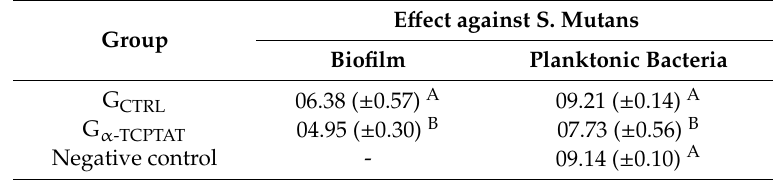
Table 3. Mean and standard deviation values of log-transformed colony-forming units/ mL (CFU/mL) for bacteria in biofilm or planktonic bacteria after the contact during 24 h with the experimental dental sealants.